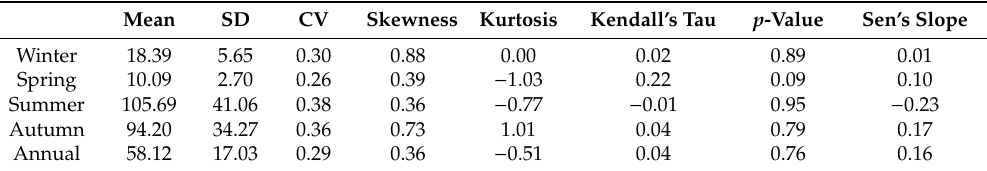
Table 4. Statistical analysis for seasonal and annual discharge record of Mainachuli stations (795) Kankai River (1972–2003).